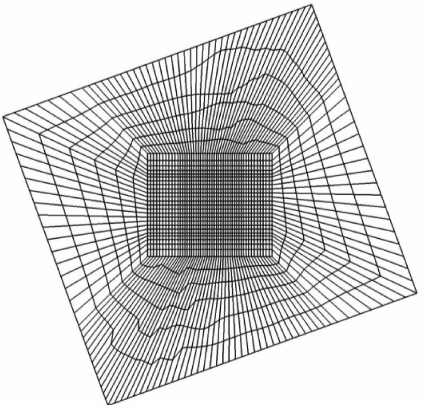
Figure 4: Key point of side wall in the main power house.